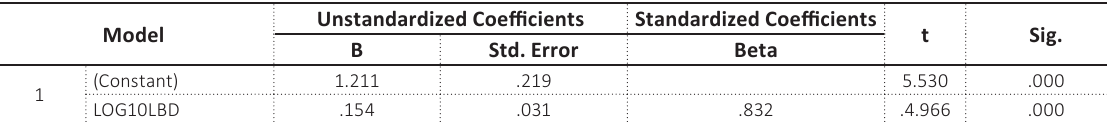
Table 5c. Coefficients result for hypothesis